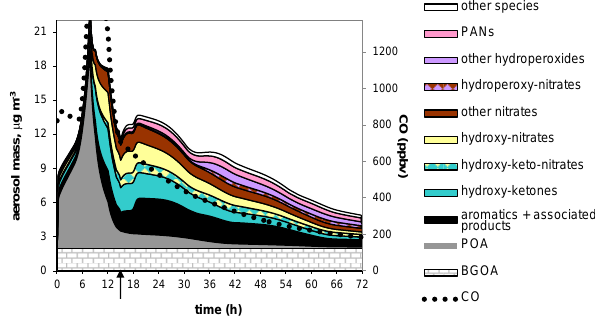
Fig. 9. Evolution of aerosol speciation with time. The arrow shows the time at which Lagrangian conditions begin. The cate- gory “aromatics + associated products” includes both substituted aromatics and non-linear products of aromatic oxidation. The scale for gas phase CO (dotted line) is chosen such that the background value (125ppbv) coincides on the plot with the level of background aerosol (2µgm − 3 )